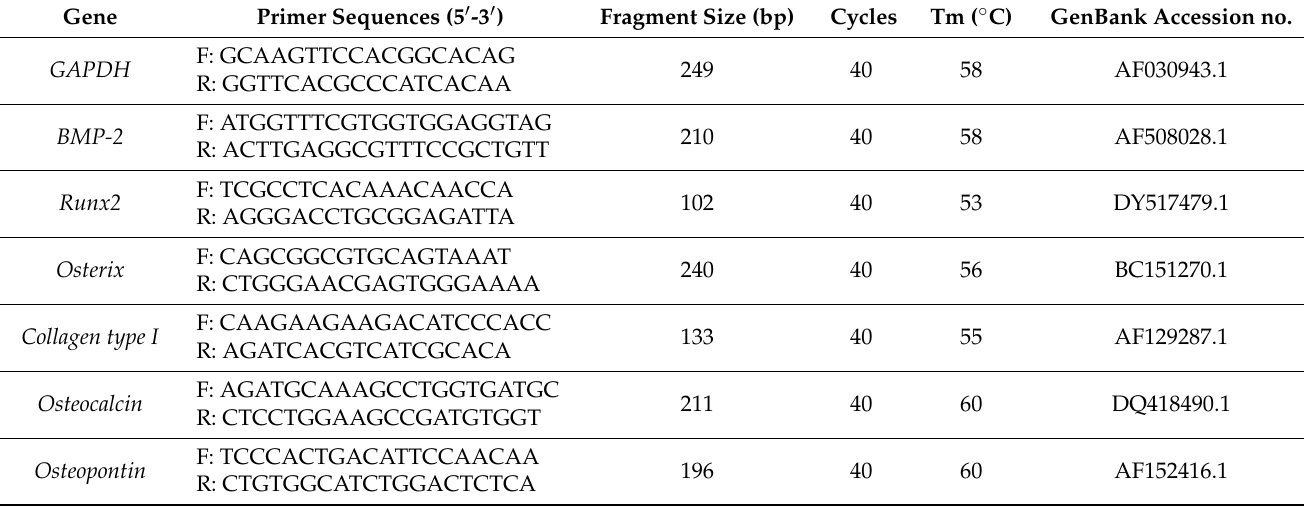
Table 1. Primer sequences for